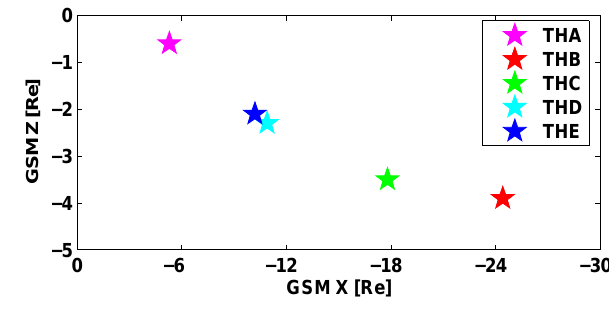
Fig. 3. Positions of THEMIS spacecraft on 22 February 2008, 04:35UT in (x,z) GSM